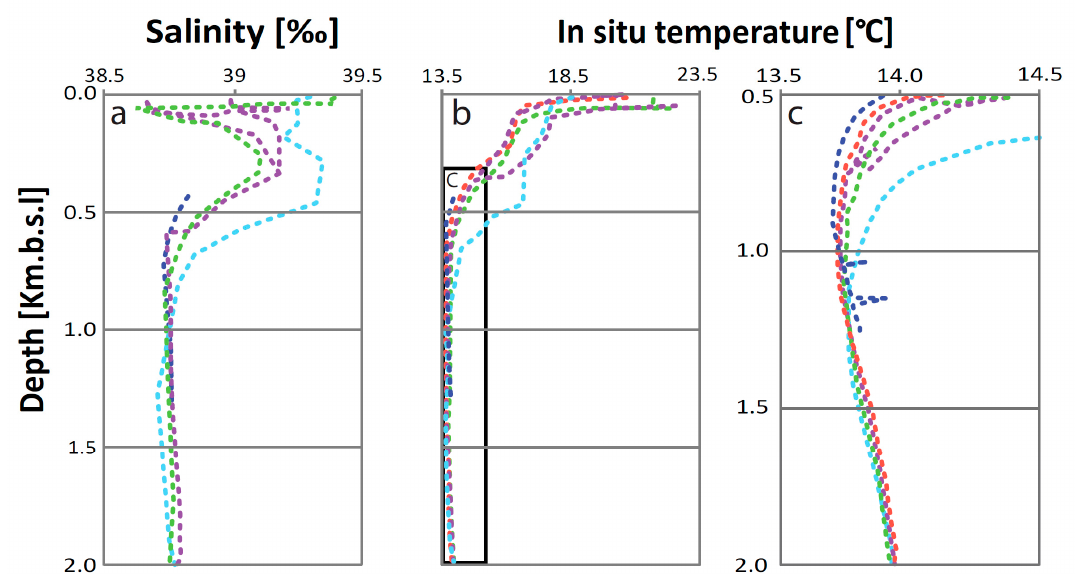
Figure 2. Seawater salinity ( a ) and temperature ( b ) profiles, measured in various locations in the EMS by CTD casts in the course of four different cruises (6901084 ‐ 06/2012 ‐ red, 6901043 ‐ 09/2012 ‐ green, 6900850 ‐ 10/2011 ‐ purple, 6900794 ‐ 01/2009 ‐ azure; from [90]) and during EV Nautilus 11/2011 ROV survey ([69]; blue). ( c ) A zoom of the in situ temperature profiles (b) in the water depth range of 0.5 to 2 km.